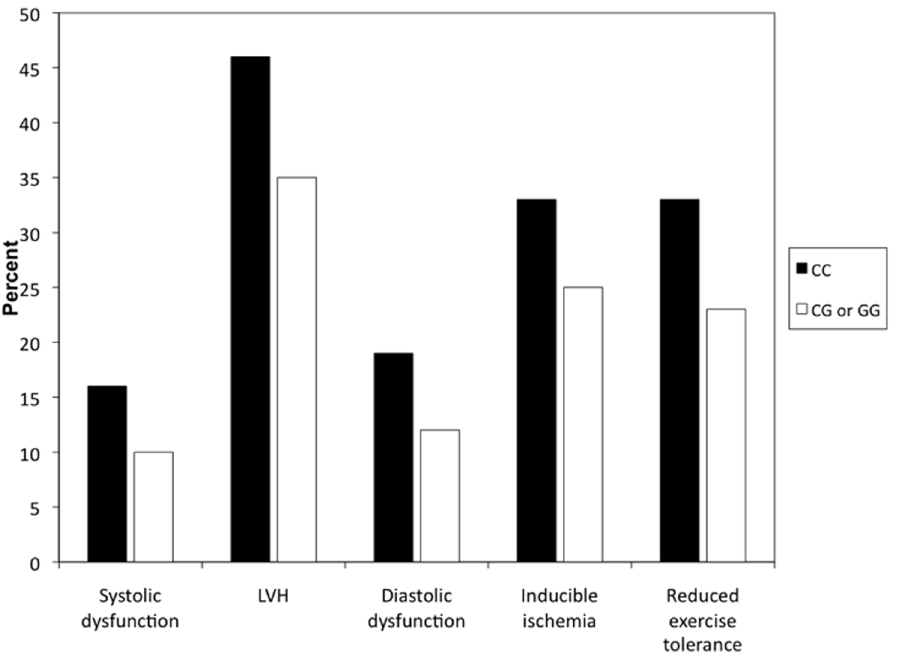
Figure 1. Proportion of participants with abnormal cardiovascular phenotype classified by genotype at rs2296545 (p , 0.05 for all comparisons).